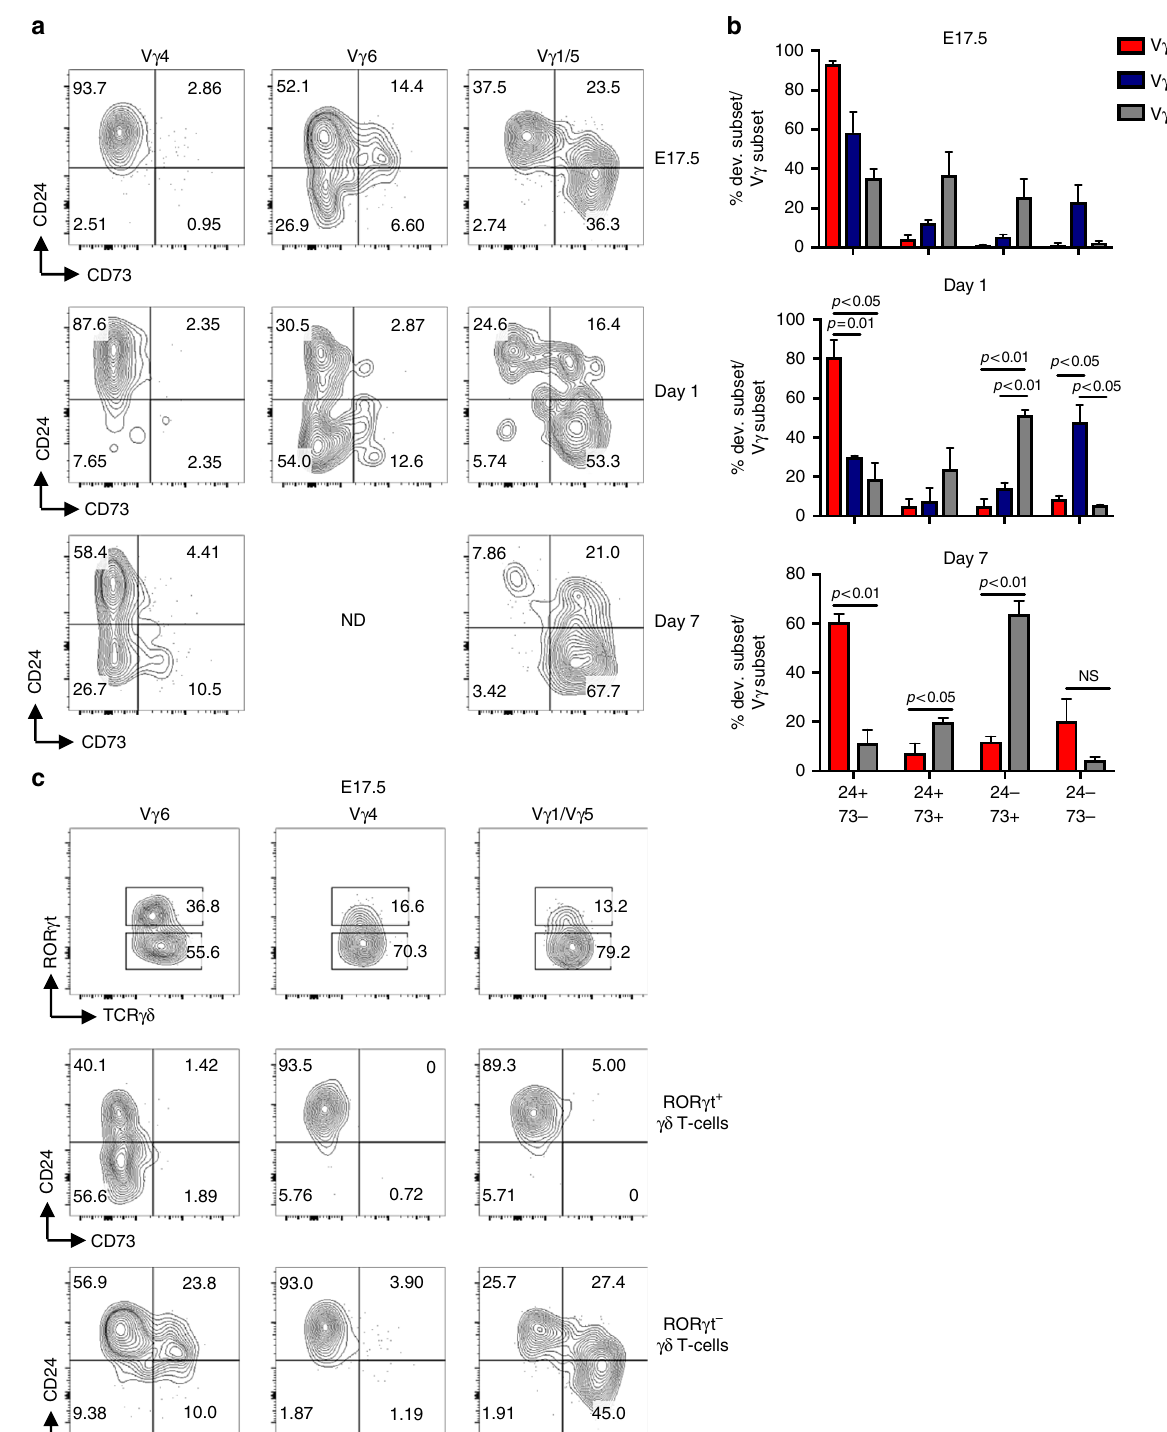
Fig. 3 Developmental pro fi les of V γ subsets. a Representative FACS plots of CD24/CD73 pro fi les of V γ 4, V γ 6, and V γ 1/5 cells in WT ex vivo thymus from mice aged E17.5, 1 day, and 7 days. b Proportions of C24/CD73 developmental subsets in each V γ population (V γ 4, V γ 6, and V γ 1/5). For E17.5, all comparisons between each subset between V γ populations are statistically signi fi cant with p < 0.05, except for the comparison of proportions of CD24 − CD73 − cells within V γ 4 vs V γ 1/5. For day 1, comparisons are not statistically signi fi cant unless otherwise indicated. c ROR γ t + and ROR γ t − populations within V γ subsets, and CD24/CD73 developmental pro fi les of ROR γ t + and ROR γ t − V γ subsets. All plots are gated on CD3 + TCR γδ + cells. Numbers in FACS plots indicate frequency within each gate. Data are representative of at least three independent mice. Center values indicate mean, error bars denote s.e.m. p -values were determined by two tailed Student's t -test. ND = not done due to low cell number, NS = not signi fi